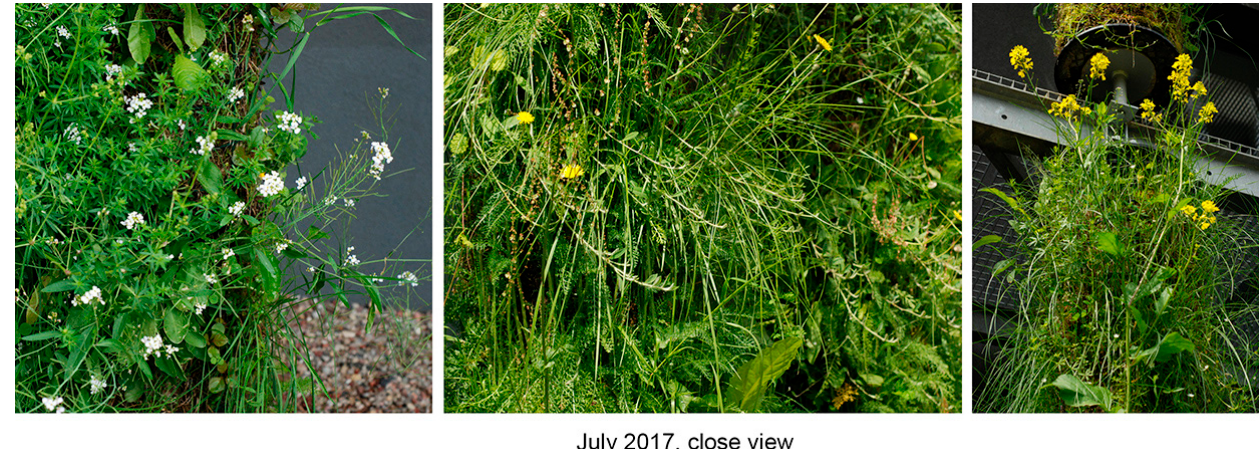
Figure 4. An example of plant species representation in the green columns, July 2017.